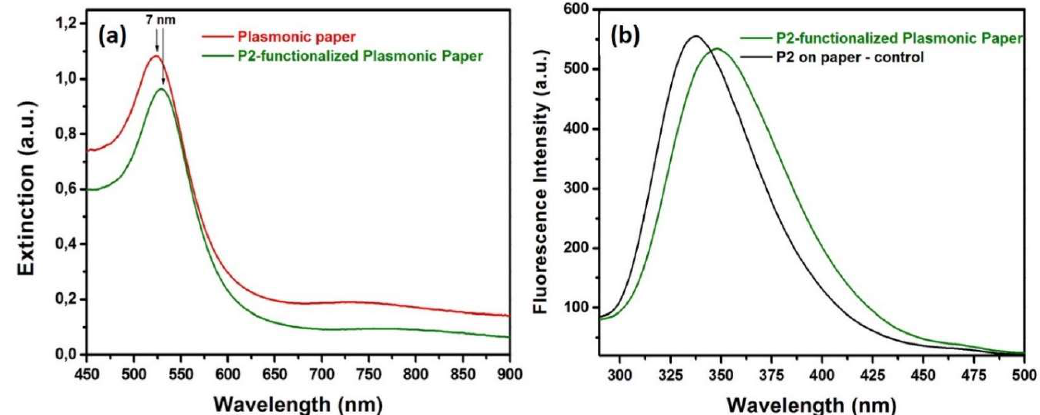
Figure 3. ( a ) The extinction spectra of the plasmonic paper before and after the functionalization with the P2 polypeptide and ( b ) fluorescence spectra of P2 on bare paper and on the designed plasmonic paper substrate.